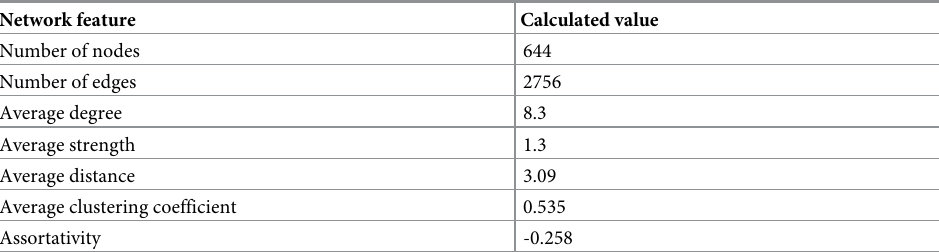
Table 2. Network features of medical providers